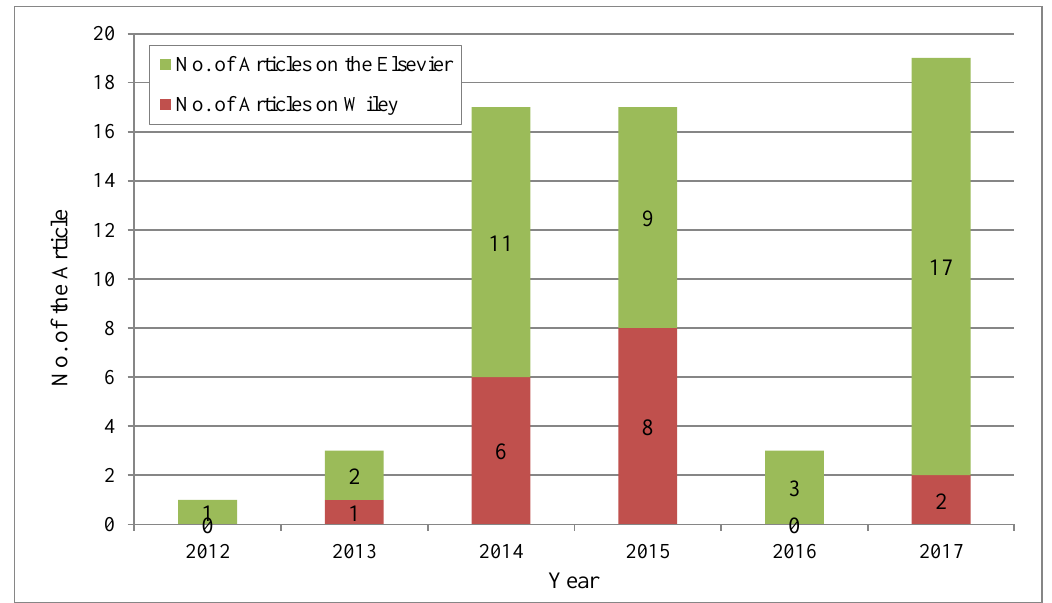
Figure 1. Diagram of the number of articles related to crowd funding available on the Elsevier and Wiley databases Ibrahim and Verliyantina (2012) designed a business model of crowd funding for small businesses in Indonesia and modified the typology of the model based on the Hamer model. The model includes donors/funders (investors), volunteers, partners of that discipline, educators and non-profit organizations which are all involved in the process screening, supervision, and management of funds (Figure 2). Also, in the modified model typology shown in Fig. 3, they added payment gateways and field workers, as two parts, to the Hamer model [21]. They determined the variables affecting crowd funding, such as repayment rate, service platforms including examination of proposals and consulting, investor confidence, Web technology infrastructure and the Internet, compliance with community features, and quality of life